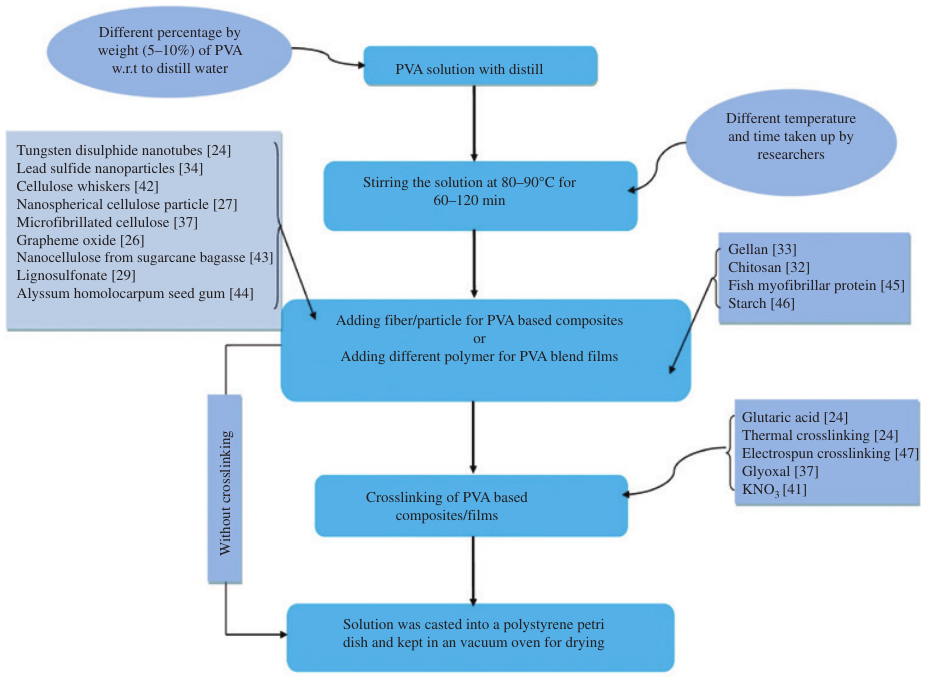
Figure 2: Preparation of PVA based